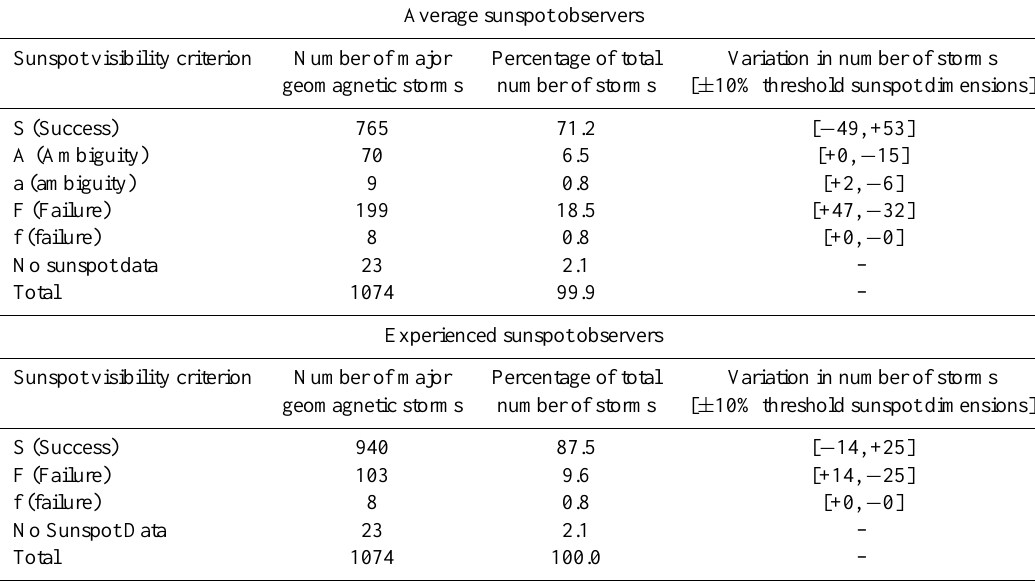
Table 2. Numbers and percentages of major geomagnetic storms in the interval 1874–1976 for which the different sunspot visibility criteria defined in Sect. 5 are satisfied. In the case of “average” sunspot observers, the five conditions (sets of inequalities or conditions) defined in the footnotes to the table are considered sequentially for each sunspot group on the solar disk, during the six-day interval immediately before the onset of each major geomagnetic storm. Similarly, in the case of “experienced” sunspot observers, the three conditions (single inequalities) defined in the footnotes are considered sequentially. For each major geomagnetic storm, a single success (S), ambiguity (A or a) or failure (F or f) is recorded (accumulated in the table) as soon as one of the sequential conditions is satisfied. The symbols U 0 and W 0 (= U 0 + P 0 ) are again used to denote the umbral and whole-spot threshold areas and 3 denotes angular longitudinal distance from the central solar meridian. For brevity, the symbol ∀ (U , W) signifies “for all values of U and W ” (or “irrespective of the values of U and W ”); similarly, ∀ (W) signifies “for all values of W ” (or “irrespective of the value of W ”). The variations in the number of major geomagnetic storms that satisfy the different sunspot visibility criteria, associated with characteristic uncertainties of ± 10% in the threshold sunspot dimensions in arc seconds, are presented in [square]